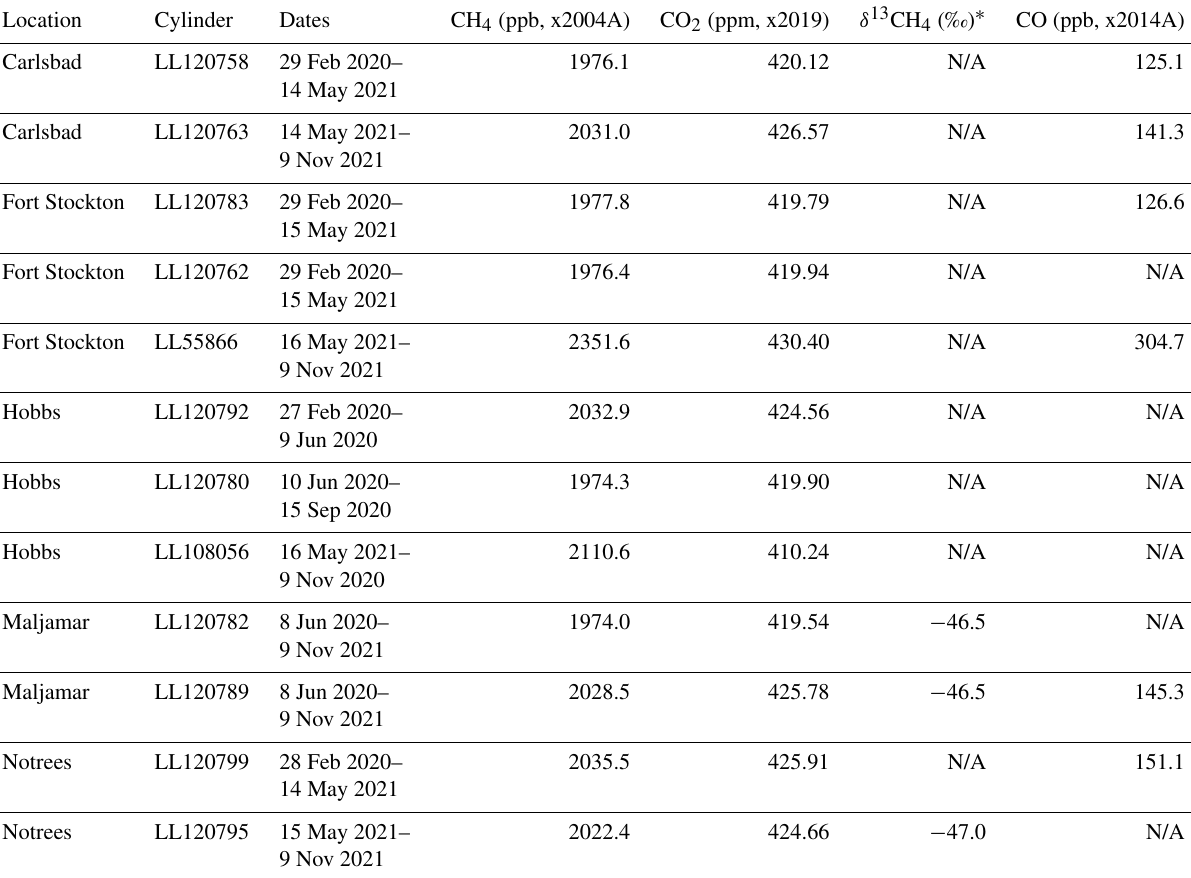
Table 2. Table of calibration cylinders used at the Permian Basin tower network sites. Within each site, the cylinders are listed in order of